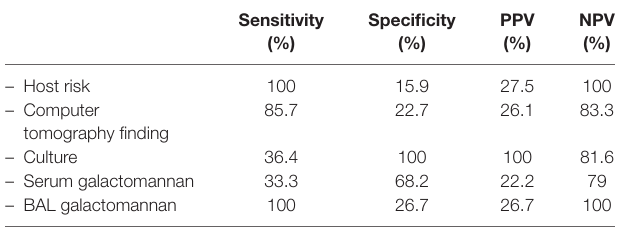
2008 consensus definition. sensitivity